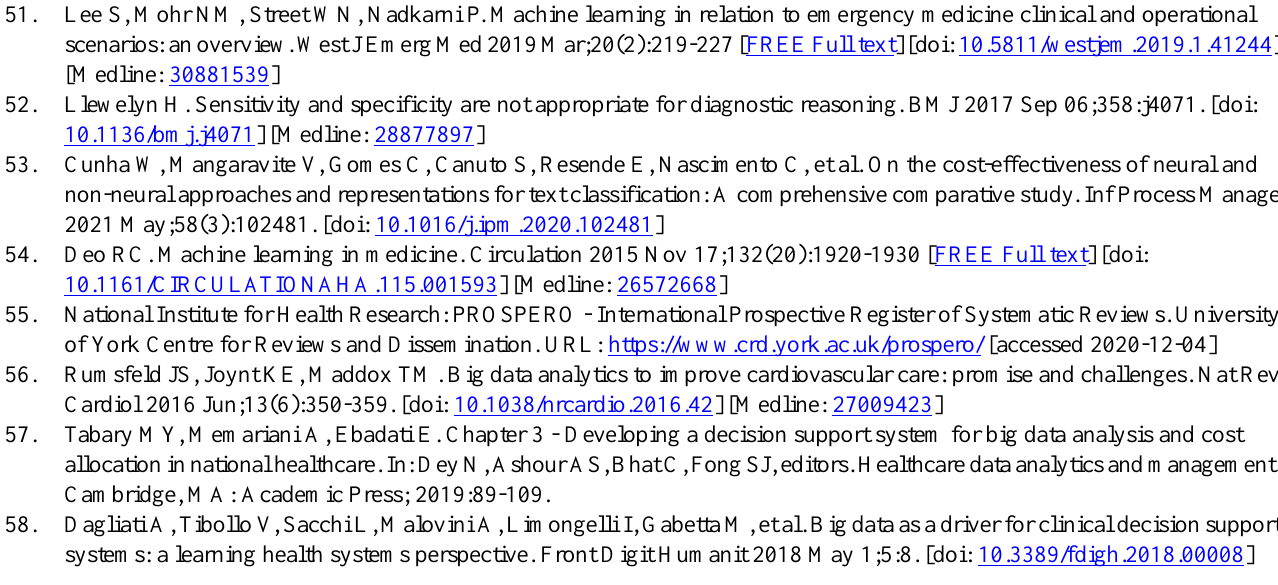
Abbreviations AI: artificial intelligence AUC: area under the receiver operating characteristic